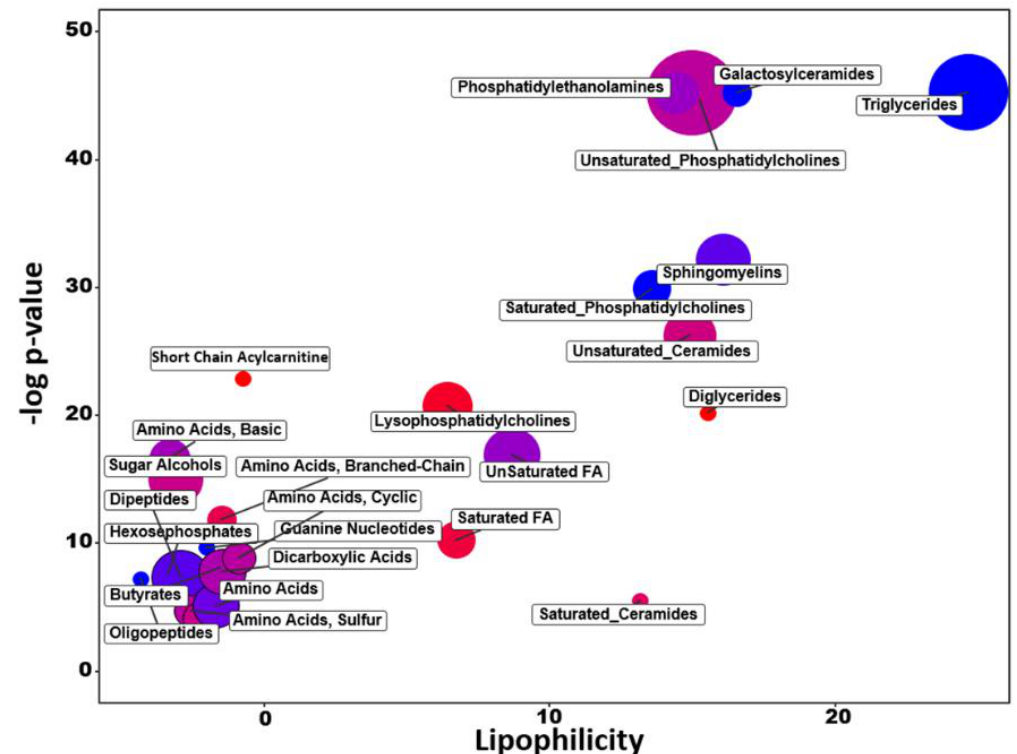
Figure 3. ChemRICH analysis in LASCPC-01 compared to LNCAP cells. Y-axis: significance of enriched sets of metabolites (FDR < 0.05); X-axis: average lipophilicity of sets of metabolites (cluster colors give the proportion of increased compounds in the LASCPC-01 cell line, red = increased levels in LASCPC-01 cells, blue = decreased levels in LASCPC-01); and circle size: number of detected compounds in this cluster.